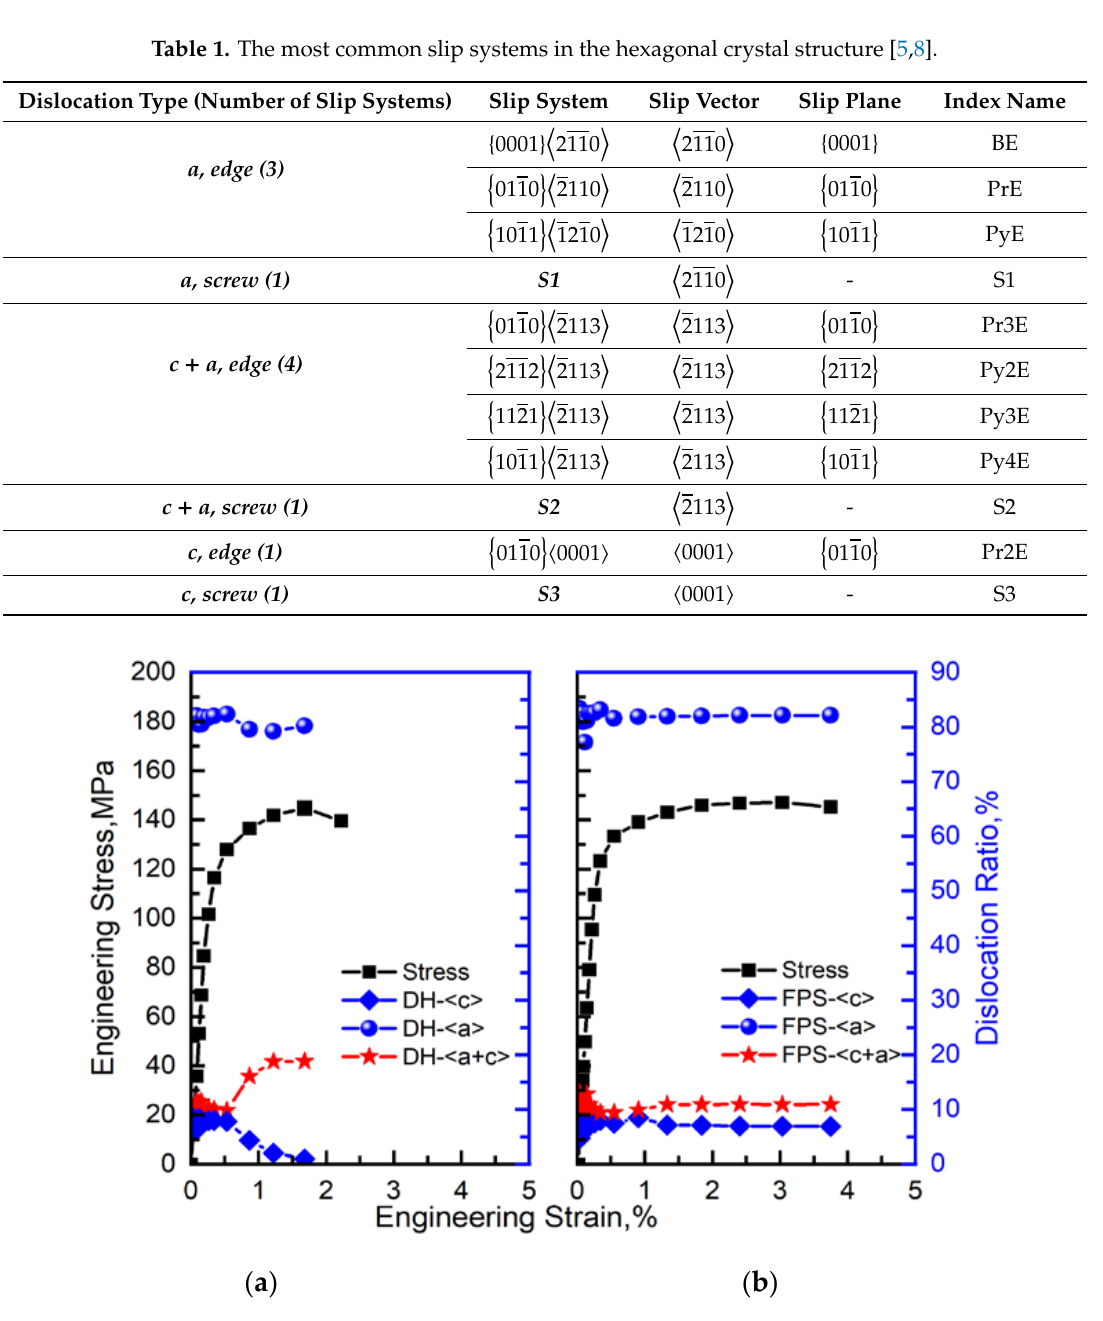
Figure 10. Relative fraction of < a > , < c > , and < c + a > dislocations during deformation of the DH ( a ) and FPS ( b ) materials. The engineering stress–strain curves are also shown.